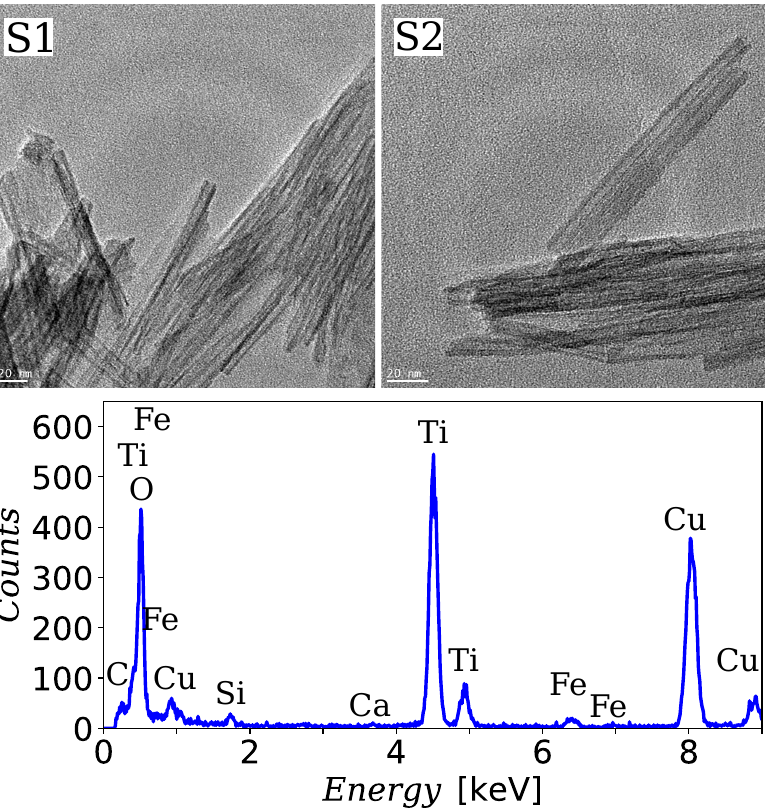
Figure 1. The upper two panels show representative transmission electron microscopy (TEM) images of samples S1 and S2. The lower panel shows the EDS spectrum for the S2 sample with characteristic peaks indicating the presence of iron